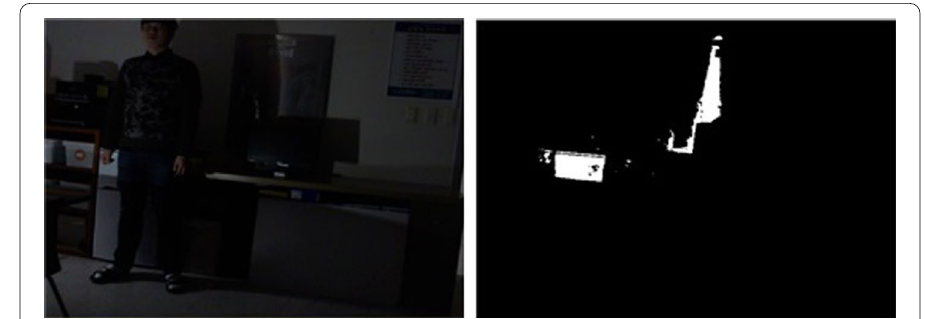
Fig. 7 Object detection result using RGB camera in nighttime